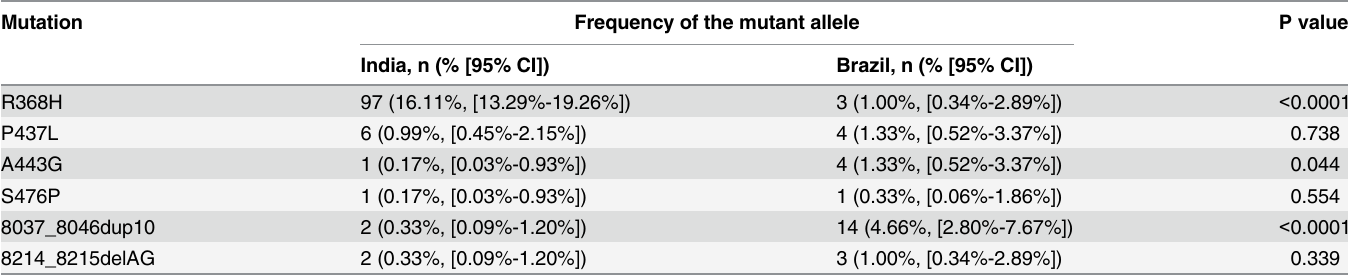
Table 3. Distribution of shared CYP1B1 mutations in the Indian and Brazilian cohorts.